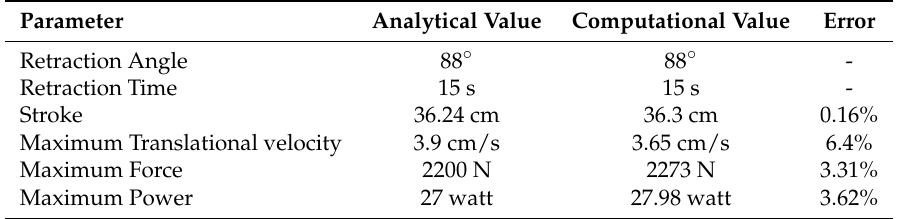
Table 2. Results